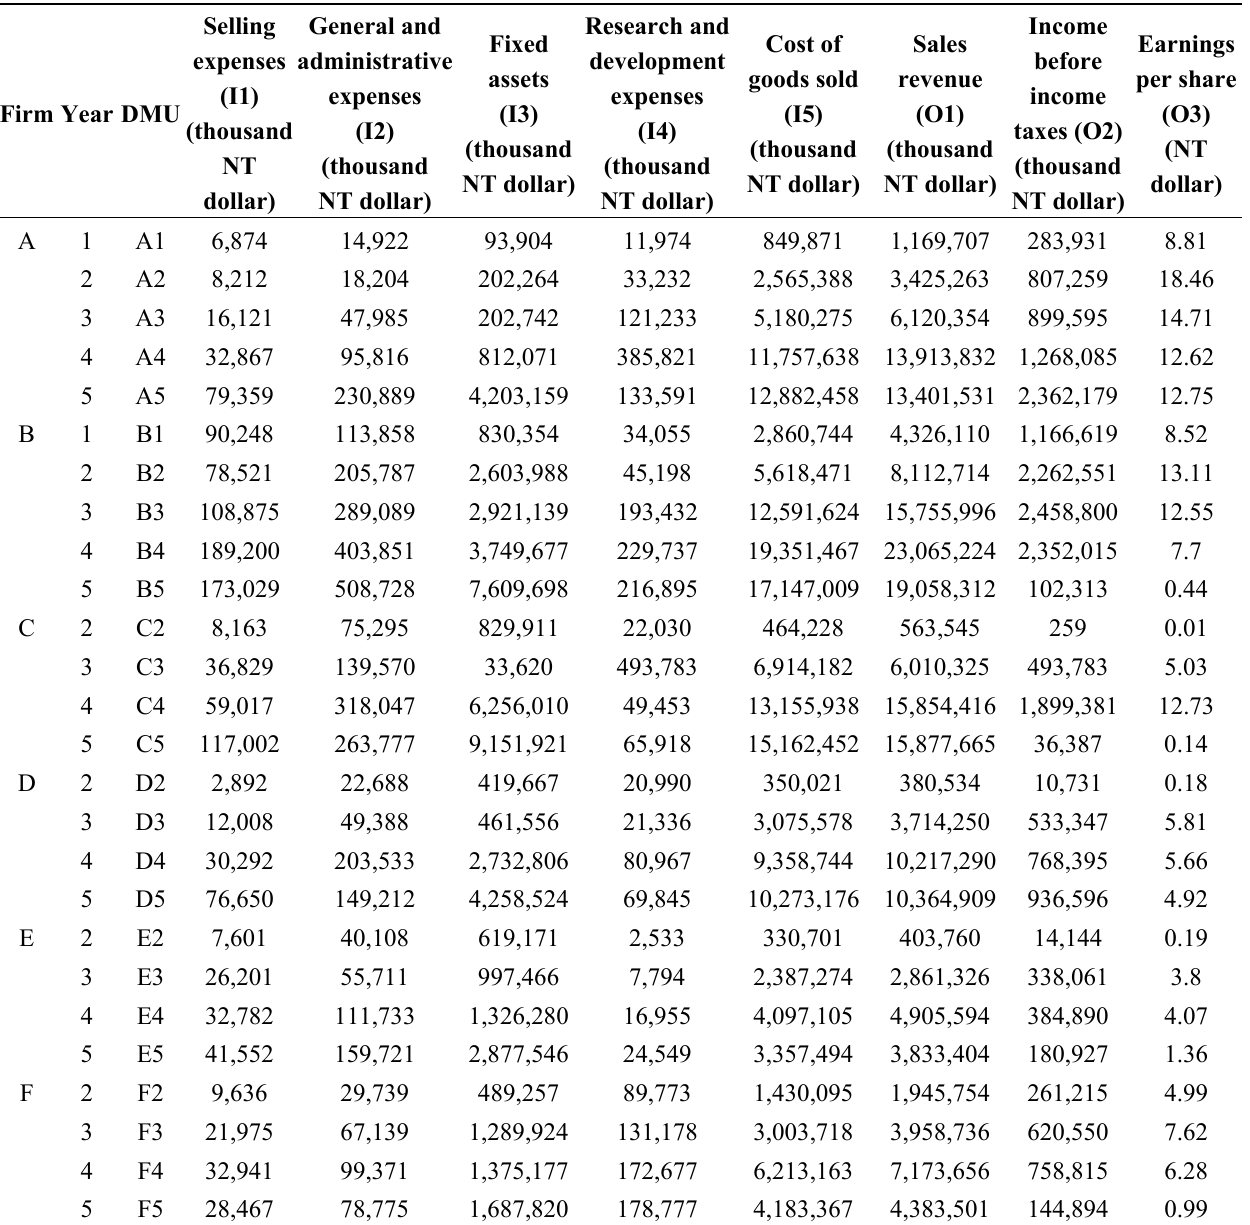
Table 3. Data of the crystalline silicon solar